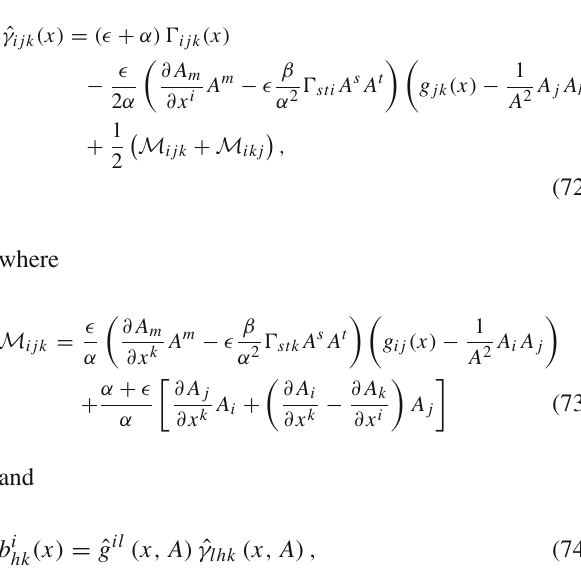
ˆ C ijk ( x , A ( x )) means that the Fins- respectively. Vanishing of lerian metric becomes A -Riemannian in this